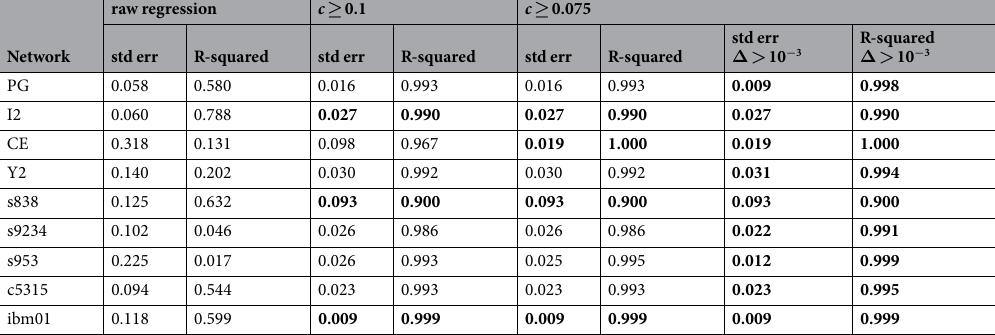
Table 2. Standard error and coefficient of determination in the fit of the power law for different thresholds defining Regions II and III. Best results are in